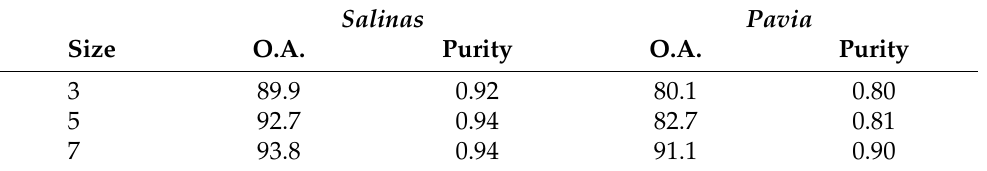
Table 3. Performance behavior with respect to the label size.